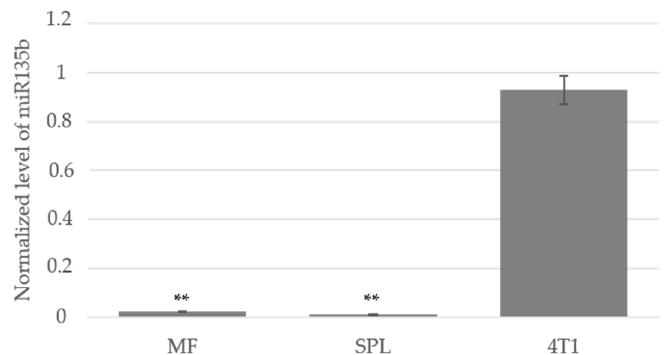
Figure A1. Expression of miR135b in different tissues. MF stands for peritoneal cells, SPL stands for splenocytes, and 4T1 represents tumor cells with high expression of miR-135b. Data are presented as the mean ± standard deviation, ** p -value < 0.01 versus 4T1 group was obtained by ANOVA.